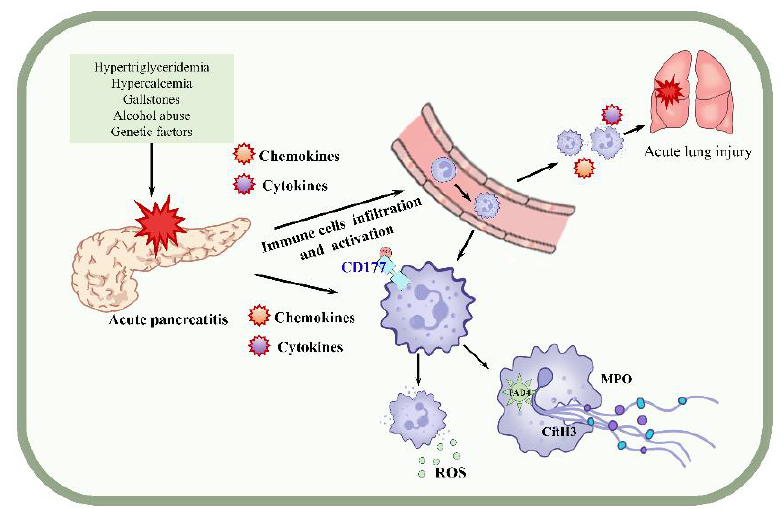
Figure 7. Mechanisms of CD177-regulated NETs in AP and AP-associated ALI.